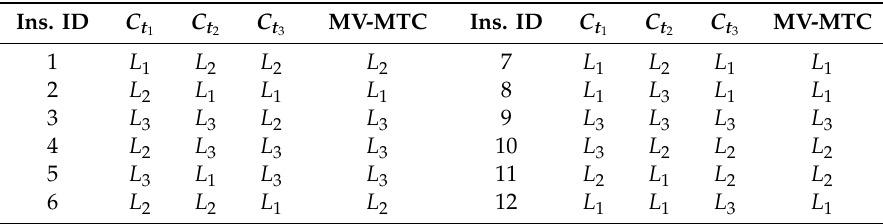
Table 5. Assignments of final cluster labels to the instances in terms of di ff erent tasks and the output of MV-MTC from majority voting rule.